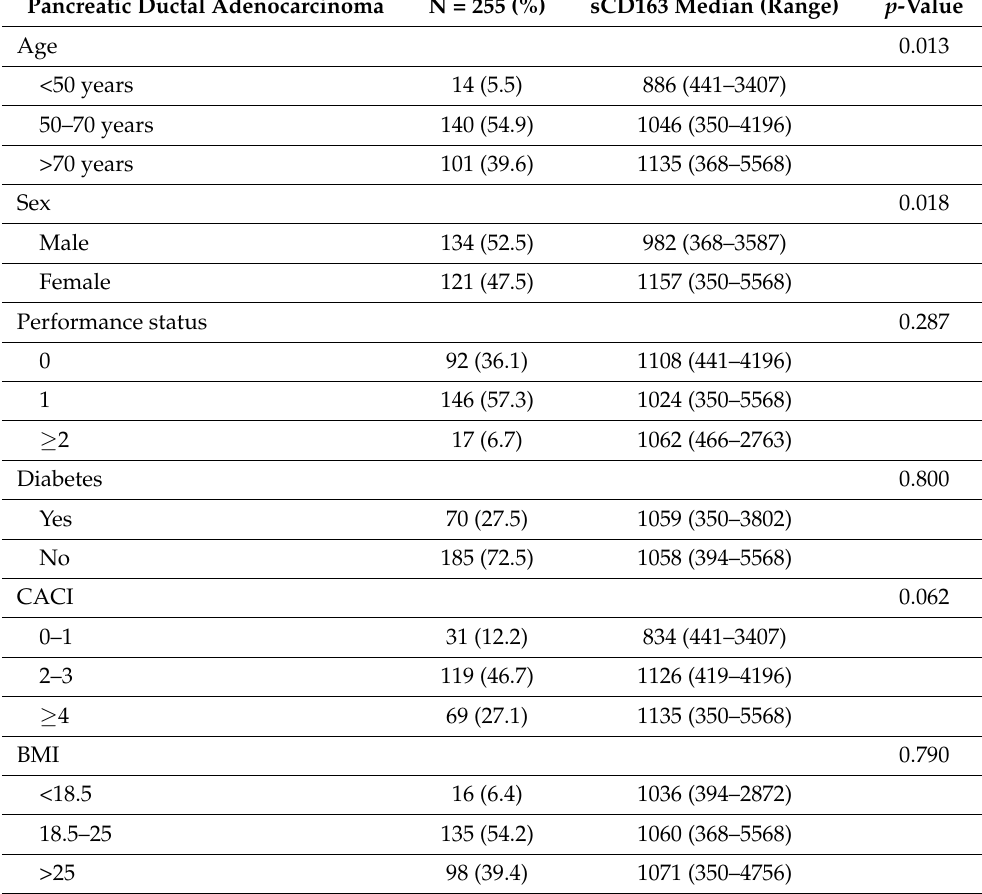
Table 1. Pretreatment sCD163 levels stratified according to clinical and tumor characteristics of the 255 patients with pancreatic ductal